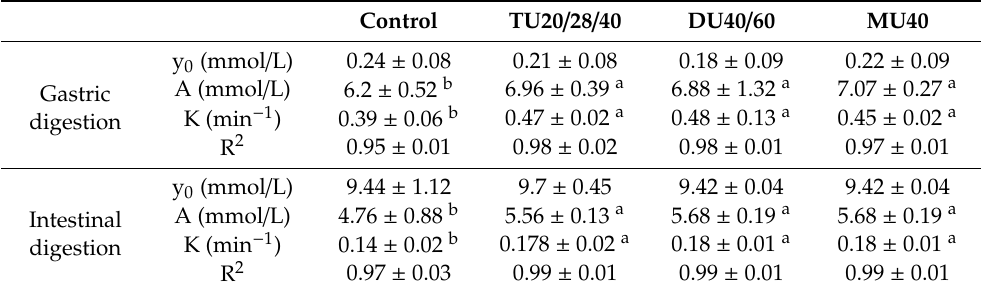
Figure 3. Effects of potato protein treated with online ultrasonic (US) treatment combined with pH shifting (pHS) and mild thermal (40 °C) (T40) treatment (US/T40/pHS) at the frequency of TU20/28/40, DU40/60, and MU40 kHz on the release of free amino group of potato protein during stomach ( A ) and intestinal ( B ) digestion. Table 1. Characteristic parameters of the first-order kinetic equation for the release of the amino group in potato protein during gastric and intestine digestion.